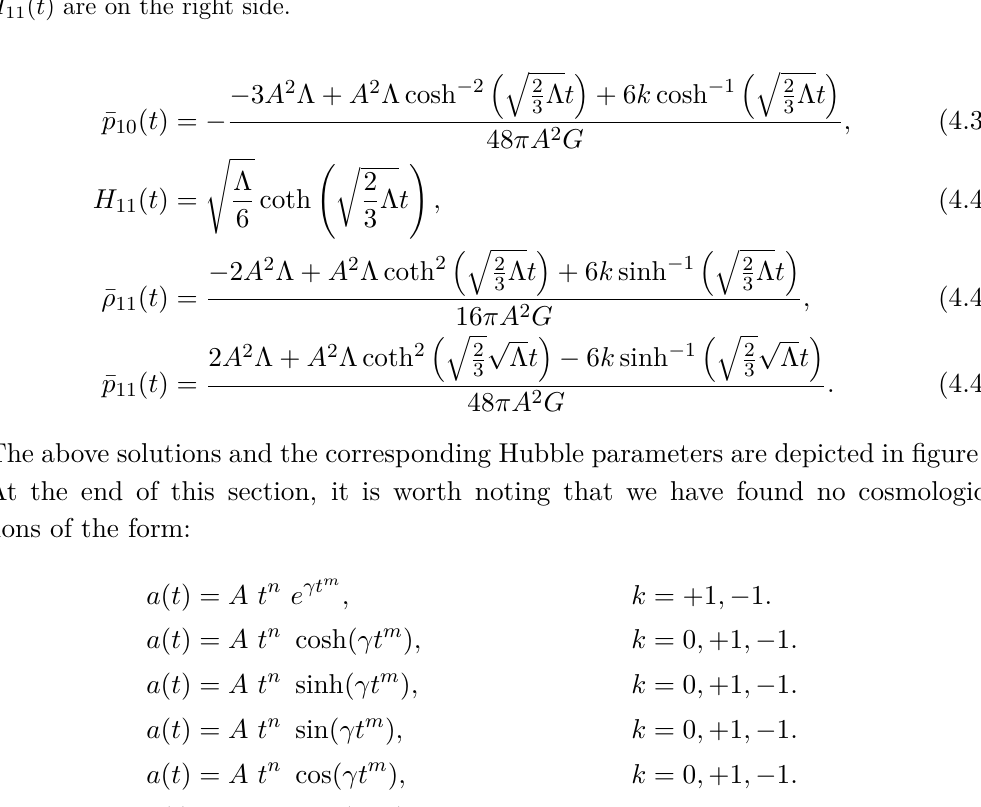
(cid:0)q (cid:1) , (blue) and 2Λ t a 11 ( t ) = 3 H 9 ( t ) , H 10 (11)